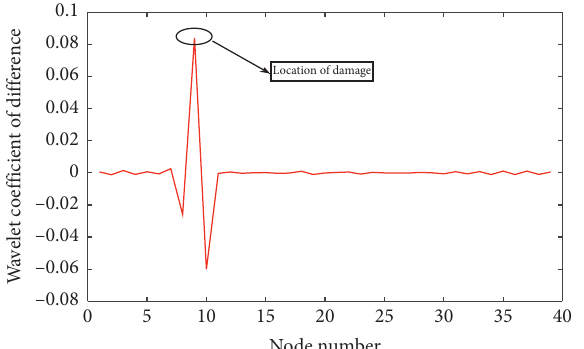
Figure 6: Wavelet coefficient difference graph for 15% damage in section 9.